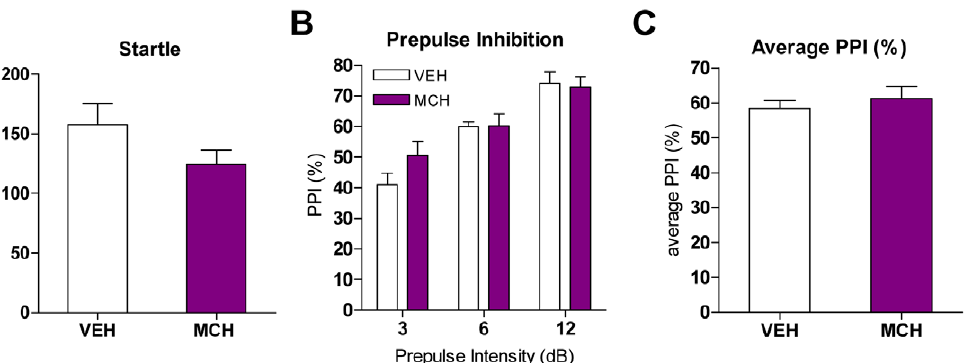
Figure 1. MCH effects on PPI in mice. A. Startle reactivities after vehicle or MCH (1 nmole) injection in mice (n=8–9). Values represent mean startle reactivity 6 SEM. B. PPI levels in mice after MCH (1 nmole) injection (n=8–9). Values represent mean % PPI 6 SEM. C. Average of PPI values after MCH injections in mice. Values represent average of % PPI elicited by three prepulse intensities 6 SEM.